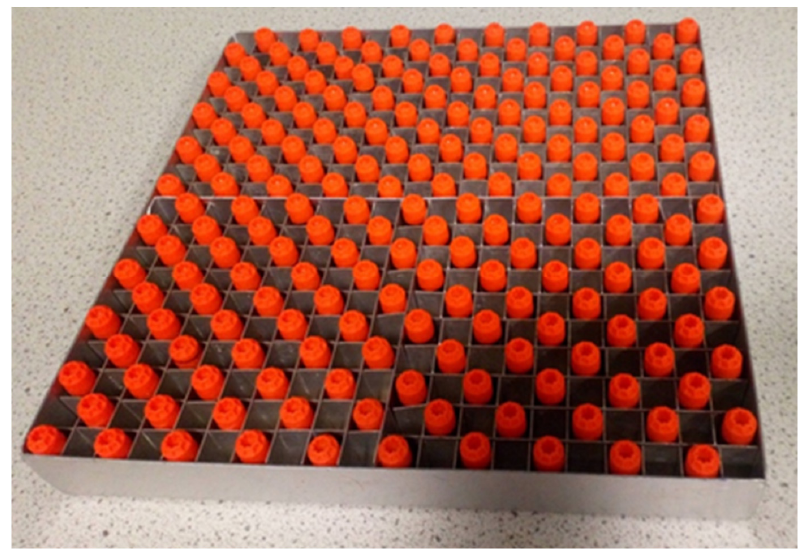
Figure 1. Correct loading of the metal oven rack for heat ‐ inactivation.